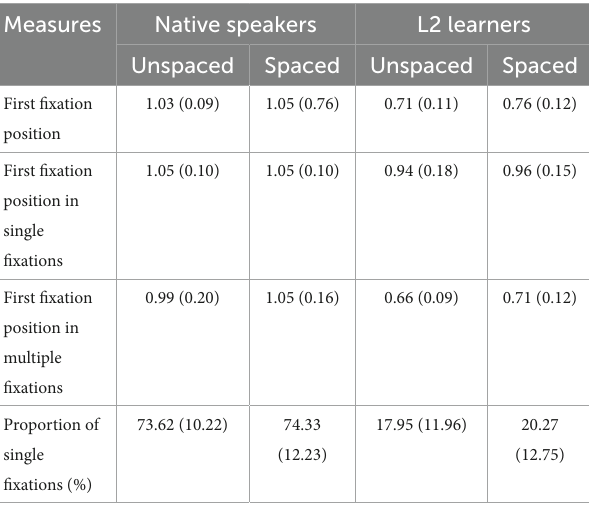
TABLE 6 Mean landing positions (in characters) in unspaced and word- based spaced texts, with SDs provided in parentheses to indicate